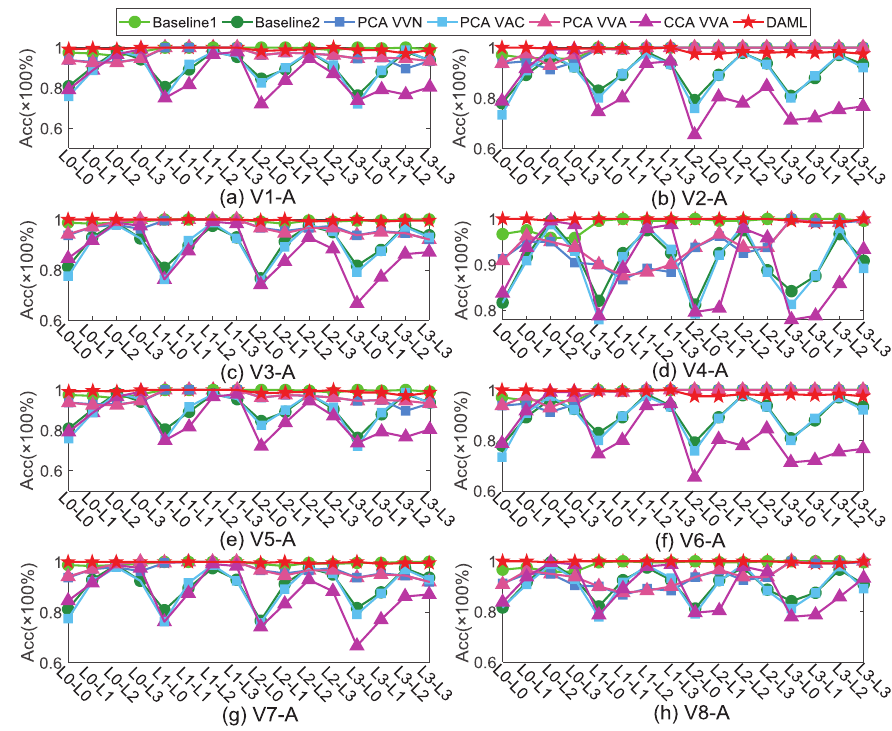
Figure 5. Diagnostic results under the condition of a 70% training sample size, ( a ) V1-A, ( b ) V2-A, ( c ) V3-A, ( d ) V4-A, ( e ) V5-A, ( f ) V6-A, ( g ) V7-A and ( h ) V8-A.